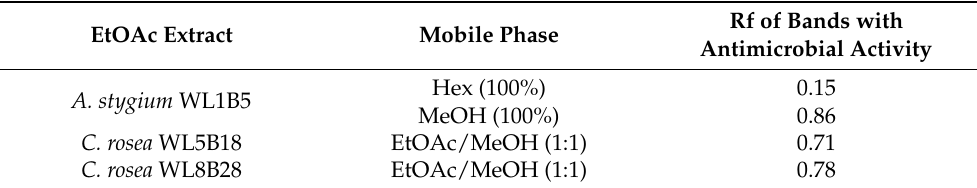
Table 5. TLC analysis and contact bioautography of mobile phases tested against E. coli ATCC 25922 with Rf